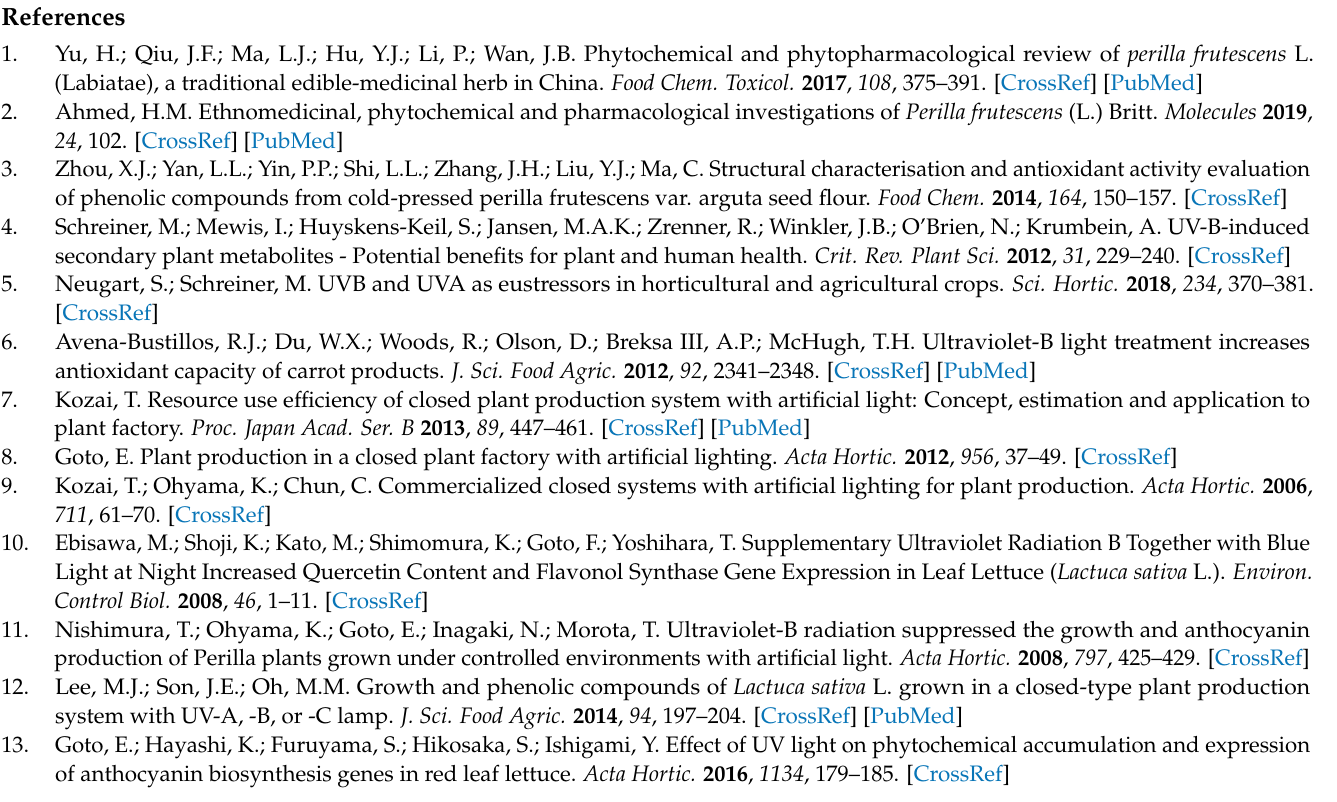
Table S3: UV irradiation conditions during experiment 2; Table S4: Primers used for the real-time PCR of phenylpropanoid and flavonoid pathway genes and the internal reference gene, actin. Figure S1: Red perilla cultivation procedure. Figure S2: The illustration of the UV lamp installation above the plants. Figure S3: Changes in dry weight, rosmarinic acid, and anthocyanin concentrations in the 4th leaves of red perilla plants. Figure S4. List of analyzed mRNAs related to phenylpropanoid and flavonoid biosynthetic